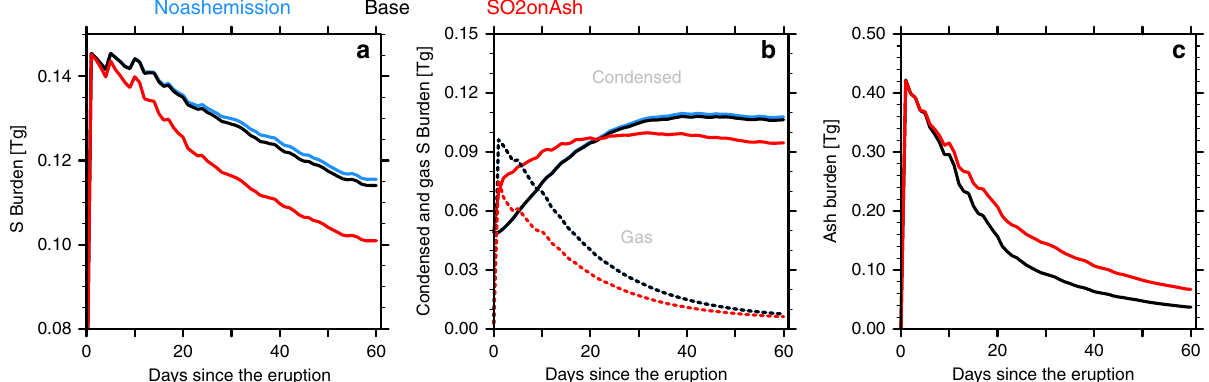
Fig. 6 The stratospheric S burden and ash burden between 33 ˚ S to 16 ˚ N. a The stratospheric S burden from the Noashemission case (blue), the Base case (black), and the SO2onAsh case (red) between 33 ˚ S to 16 ˚ N; b the condensed phase (solid) and the gas phase (dotted) S burden. The gas S burden of the Noashemission case and the base case are nearly identical; c The stratospheric ash burden. The stratospheric background S burden is ~0.052 Tg within this